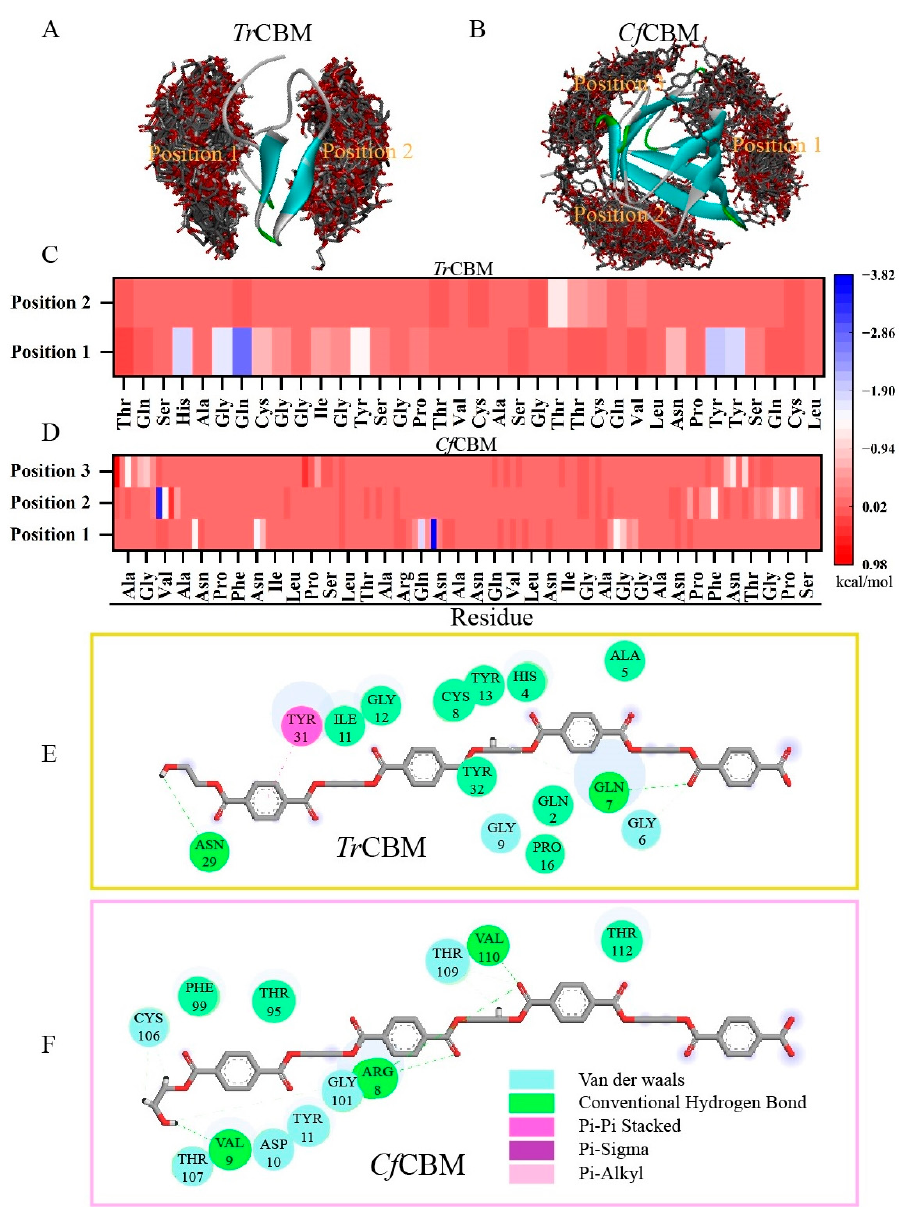
Figure 1. The binding modes of Tr CBM ( A ) and Cf CBM ( B ) to PET-4 confirmed by blind molecular docking studies using AutoDock Vina software. Molecular graphics were performed using Discovery Studio 4.0. Residue-free energy decomposition of the binding site between Tr CBM ( C ) or Cf CBM ( D ) and PET-4 in the 500 ns of MD simulation using Amber16. Two-dimensional diagrams for the interaction analysis of Tr CBM-Position 1 ( E ) and Cf CBM-Position 2 ( F ) with PET-4, in which the gray and red lines represented the carbon and oxygen in the ligand and the circles with different colors represented the main types of force acting on the residues.